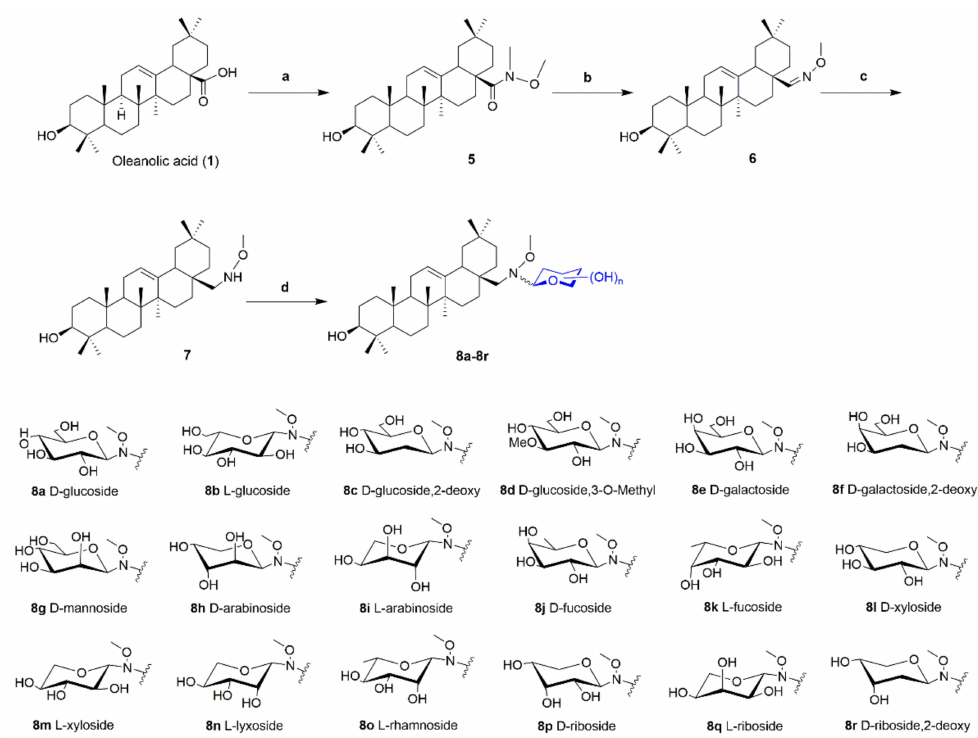
Scheme 2. Synthesis of oleanolic acid C-28-neoaglycone 7 and neoglycosides 8a – 8r . Reagents and conditions : ( a )